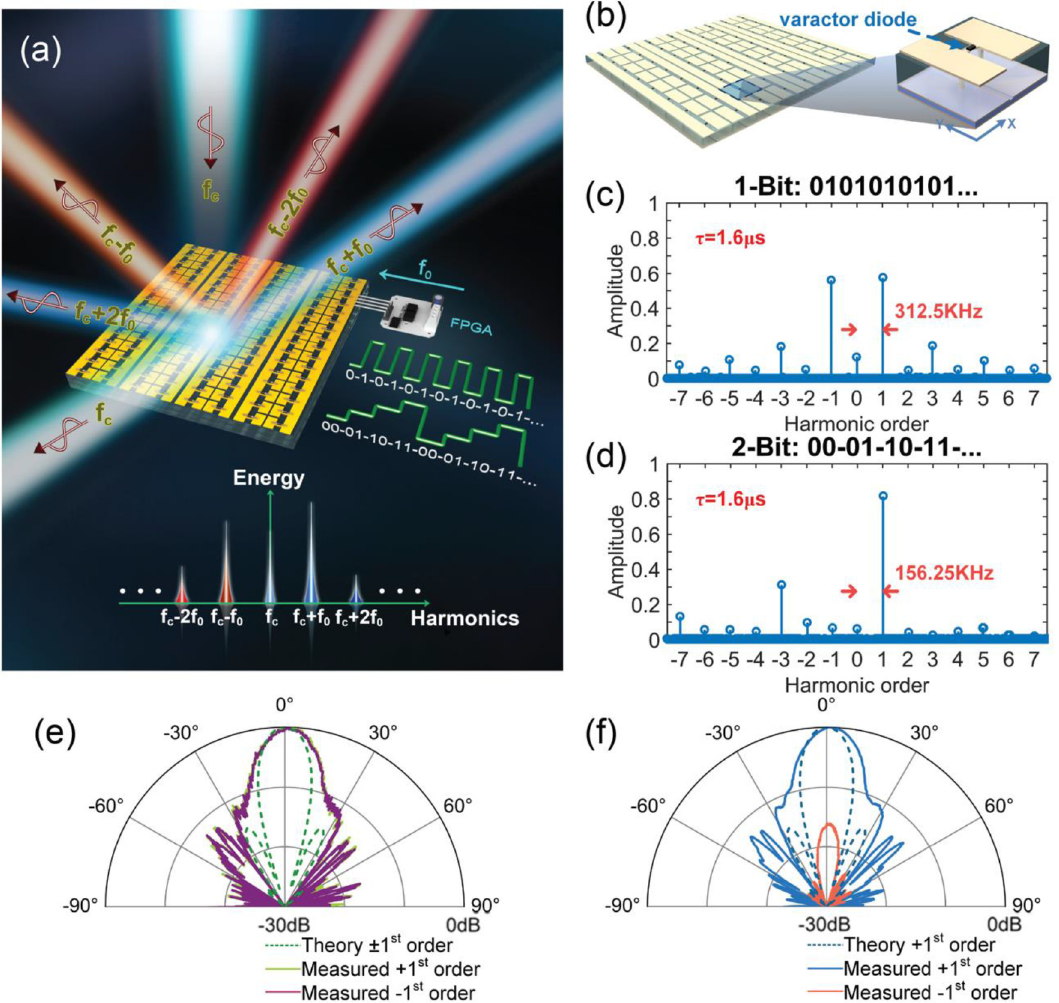
Fig. 5. Nonlinear harmonic manipulation via time coding (adapted from [32]). (a) Conceptual illustration. (b) Schematic of a coding element featuring a varactor diode. (c, c) Examples of measured spectral distributions, for 1-bit and 2-bit coding, respectively. (e, f) Corresponding scattering patterns (theoretical and measured) for the harmonic orders +1 and (cid:3)